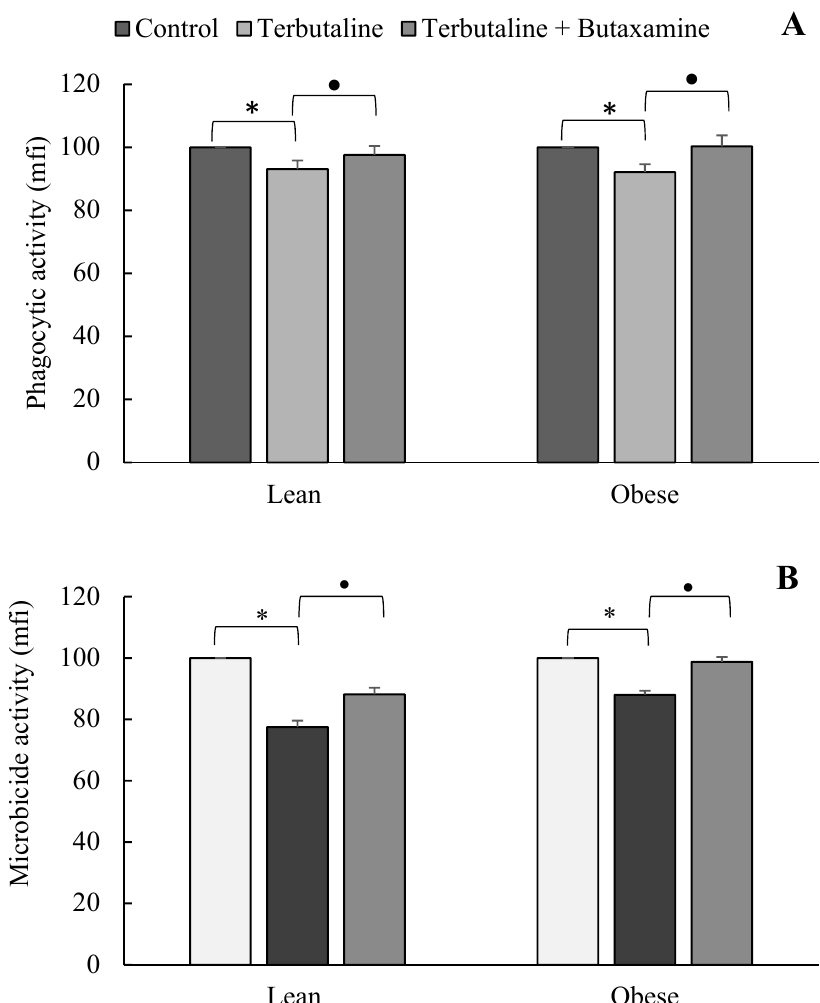
Figure 2. E ff ect of the β 2-adrenergic agonist terbutaline and β 2-adrenergic antagonist butaxamine on the phagocytic activity (mean fluorescence intensity, mfi) ( A ) and microbicide activity (mfi) ( B ) of peritoneal macrophages from lean and obese mice, expressed as the percentage change from baseline (giving “100” to control values in the absence of terbutaline and butaxamine). Columns represent the mean ± SEM of independent assays performed in duplicate. * p < 0.05 with respect to the corresponding control value; • p < 0.05 with respect to the corresponding terbutaline value. Table 2. E ff ect of the β 2-adrenergic agonist terbutaline and β 2-adrenergic antagonist butaxamine on the phagocytic percentage and microbicide percentage of peritoneal macrophages from lean and obese mice.